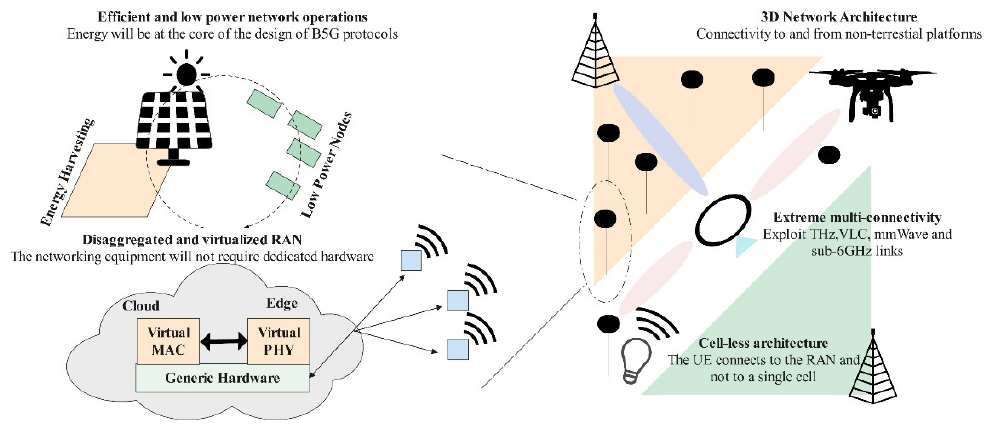
Figure 2. The architectural advancements in B5G networks.